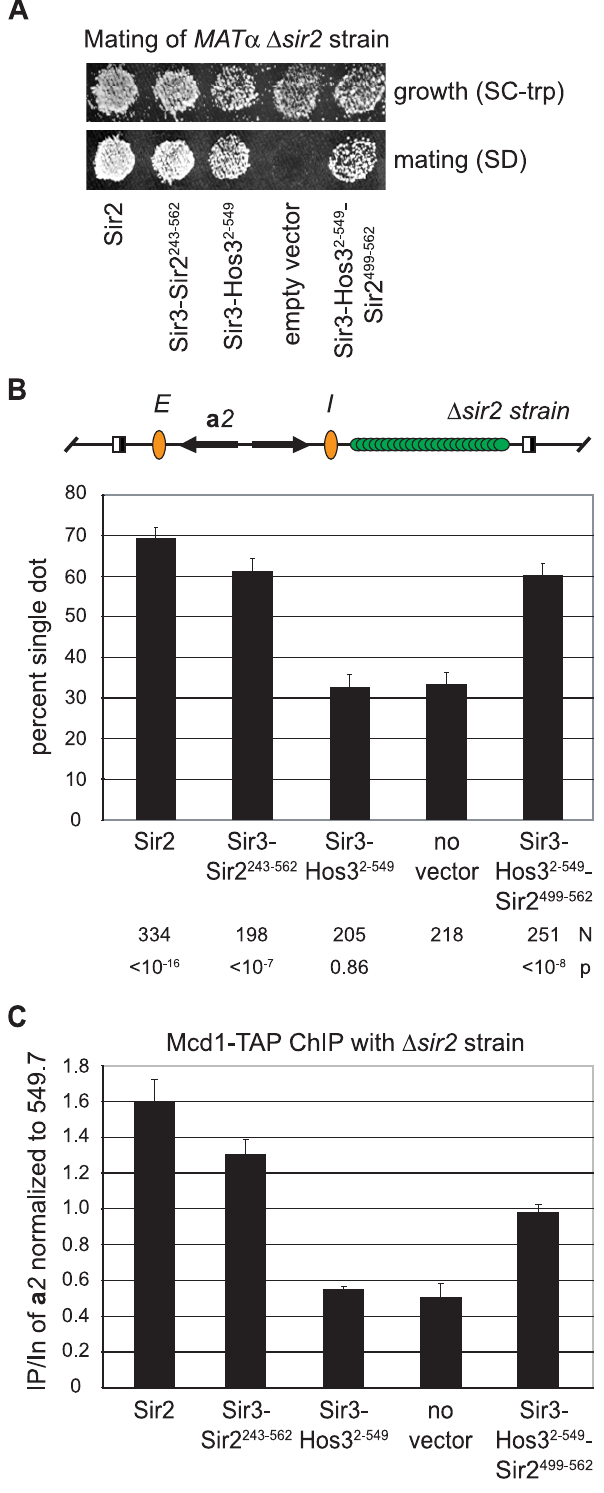
Figure 7. Cohesion persists in the absence of rDNA -specific, protein partners of Sir2. Colocalization of DNA circles bearing the 6lex op ssEB silencer was measured in strains CSW42 ( D sir2 ), CSW65 ( D csm1 D sir2 ), CSW68 ( D tof2 D sir2 ) and CSW66 ( D lrs4 D sir2 , only two trials) expressing lexA-Sir2 243–562 (pCSW1).